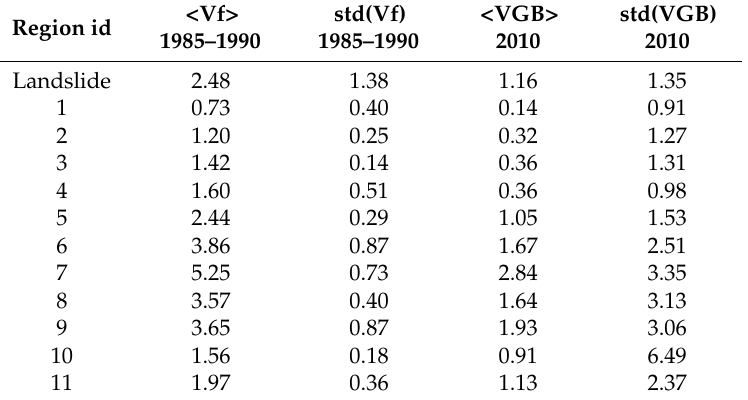
Table 3. Available literature data, in meters per year, as reported in [22,29,30]. Vf is the displacement velocity measured with field instruments between 1985 and 1990. VGB is the displacement velocity estimated through Ground-Based Synthetic Aperture Radar Interferometry (GBInSAR) in 2010. Region id